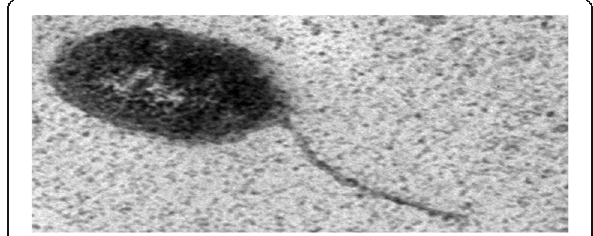
Fig. 3 Electron microphotograph of Aeromonas hydrophila isolate A.S with one polar flagellum (static growth on NB, 24 h; X